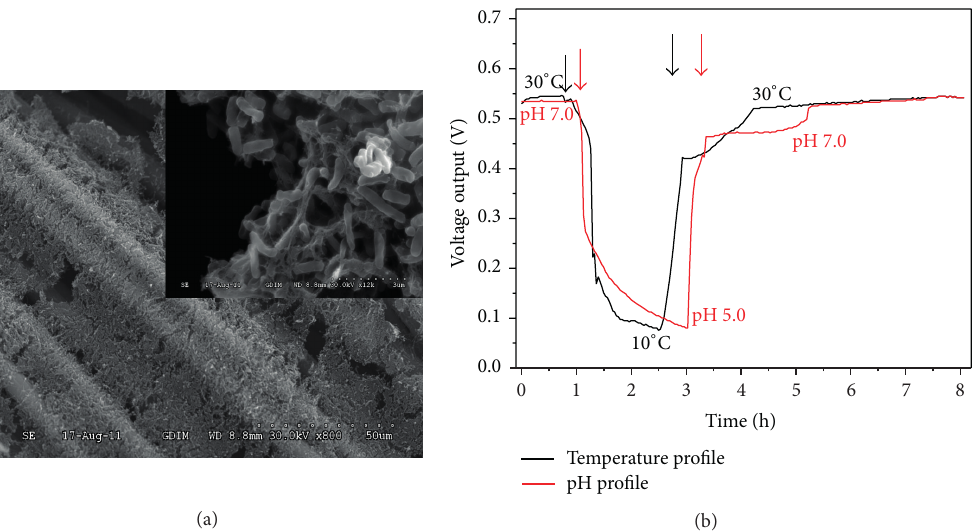
Figure 1: (a) SEM images of the anode biofilm (inset: high resolution image); (b) voltage output versus time curves with the variation of temperature and